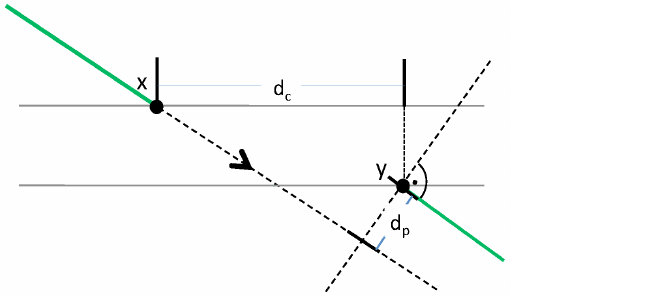
Figure 7. Endpoint distances. d c ( x , y ) is the direct distance, which is computed as the horizontal distance between x and y . d p ( x , y ) is the projected distance, which is computed by projecting x along the line orientation at x onto a plane through y that is perpendicular to the orientation at y